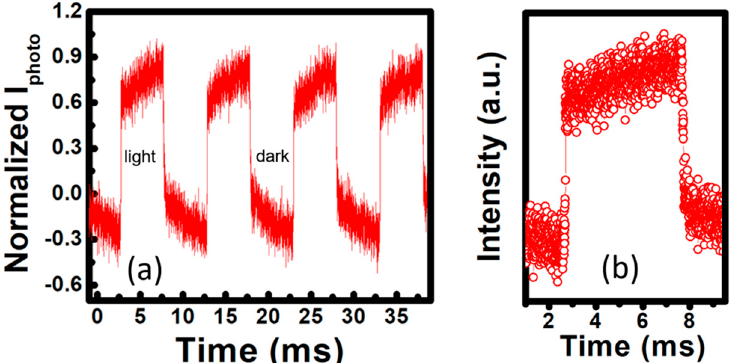
Figure 6. ( a ) The time trace of the photocurrent under periodic illumination. ( b ) The temporal photoresponse of as-fabricated device.